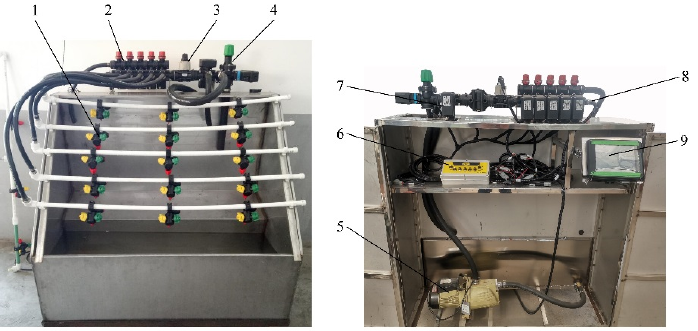
Figure 8. The maximum head of the self-priming ejector is 50 m, the maximum suction is 9 m, and the maximum flow rate is 83.3 L/min. The controller uses Intel AtomTM processor E3845, 4G DDR3L memory, five-wire resistive touch screen. The maximum diameter of the electric proportional valve spool is 19 mm, and the maximum flow rate is 1016 L/min under 0.15 MPa pressure.